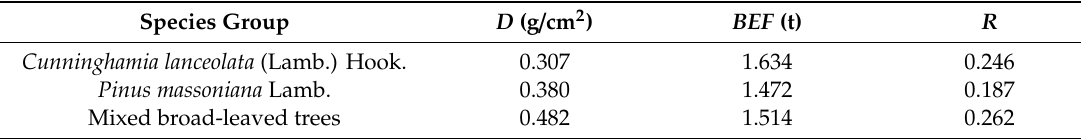
Table 1. Estimation of biomass